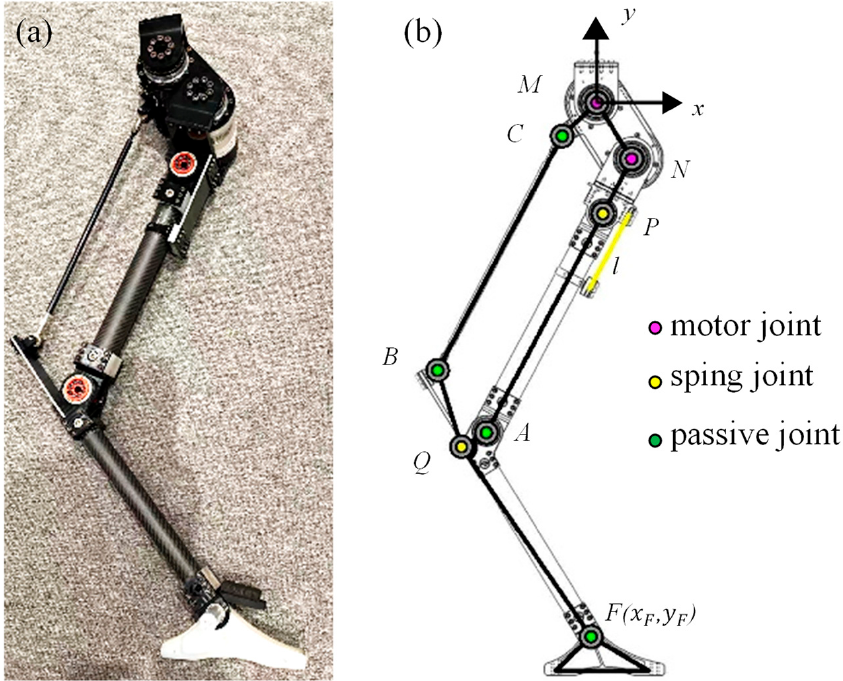
Figure 2. Schematic diagram of the single-leg structure: ( a ) prototype, ( b ) schematic diagram of the structure.